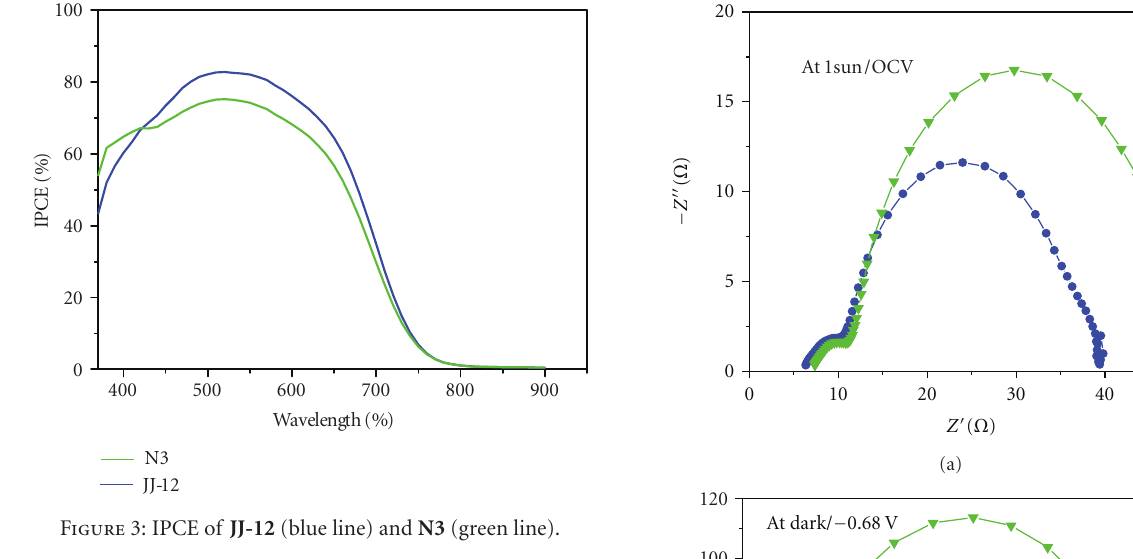
global AM1.5 solar condition, the JJ-12 sensitized cell gave a short-circuit photocurrent density ( J sc ) of 16.47 mAcm − 2 , an open-circuit voltage ( V oc ) of 0.71 V, and a fill factor of 0.71, corresponding to an overall conversion e ffi ciencies η of 8.34%. The photovoltaic performance of the JJ-12 and N3 sensitized cells is presented in Table 1. Under the same condition, the N3 sensitized cell gave a J sc of 14.52 mAcm − 2